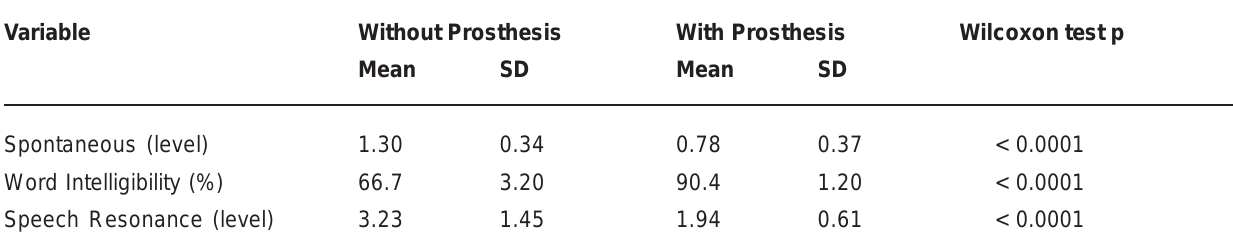
TABLE 2- Means and standard deviation (SD) scores for spontaneous speech, word intelligibility, and speech resonance for 23 patients with and without palatal obturator